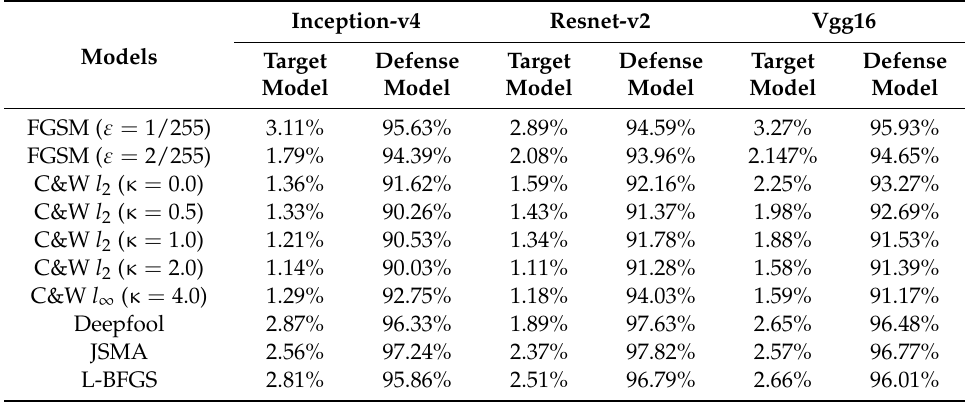
Table 3. The results of the proposed method under the defense-unaware